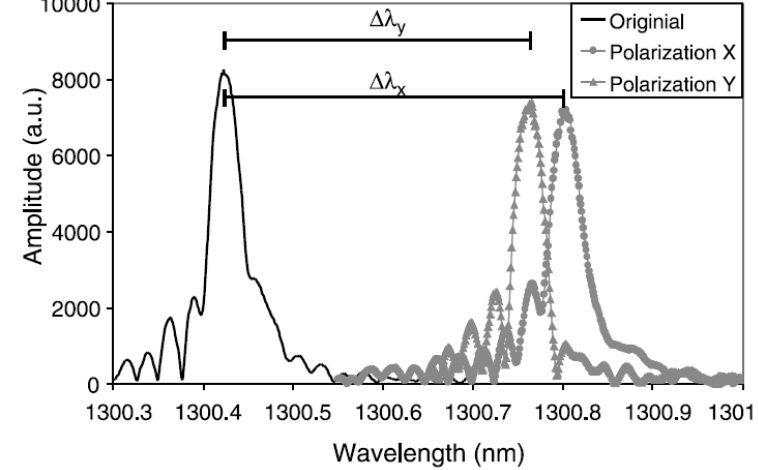
Figure 8. Spectral measurements of an embedded FBG before and after curing, using a tuneable laser with polarization control. The two right-hand peaks represent the two major polarization axes